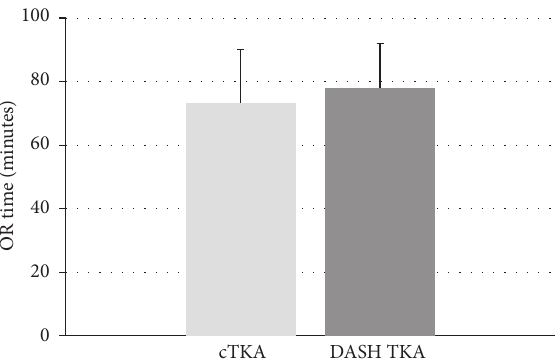
Figure 5: Interobserver reliability. mFA-mTA was measured on standardized full-length weight-bearing radiographs by two inde- pendent observers (Observer 1 and Observer 2) and Pearson’s correlation coefficient ( 𝑟 ) was calculated ( ∗∗∗ 𝑝 < 0.0001 ).